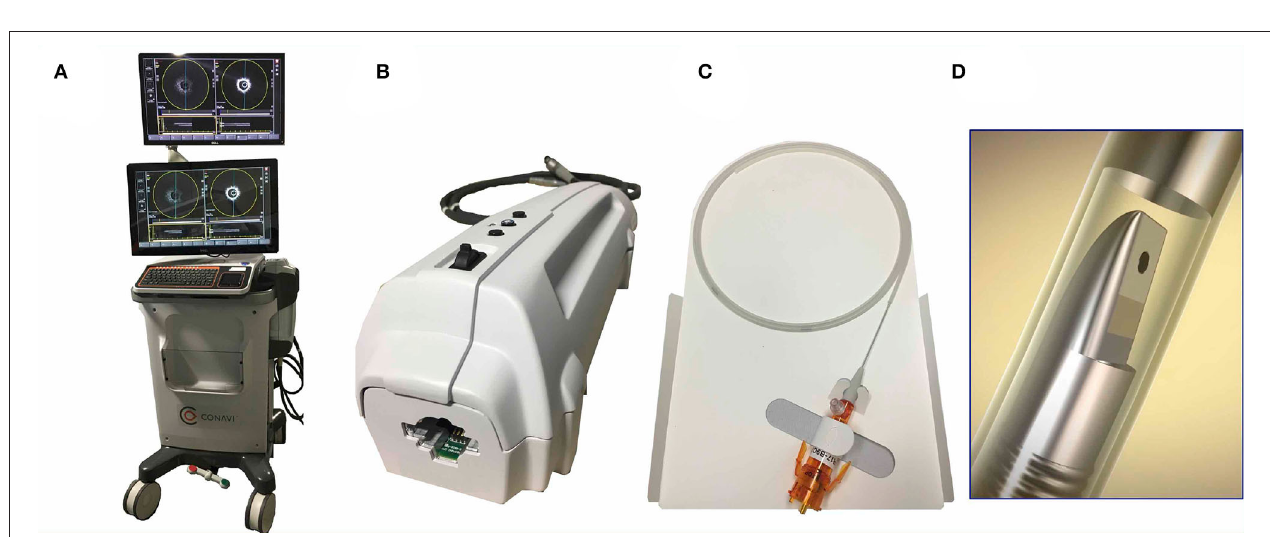
FIGURE 4 | CONAVI Novasight hybrid imaging catheter; external appearances. (A) A whole appearance of system body. (B) Interface module. (C) Catheter technical specifications. (D) The transducer. IVUS, intravascular ultrasound; OCT, optical coherence tomography.